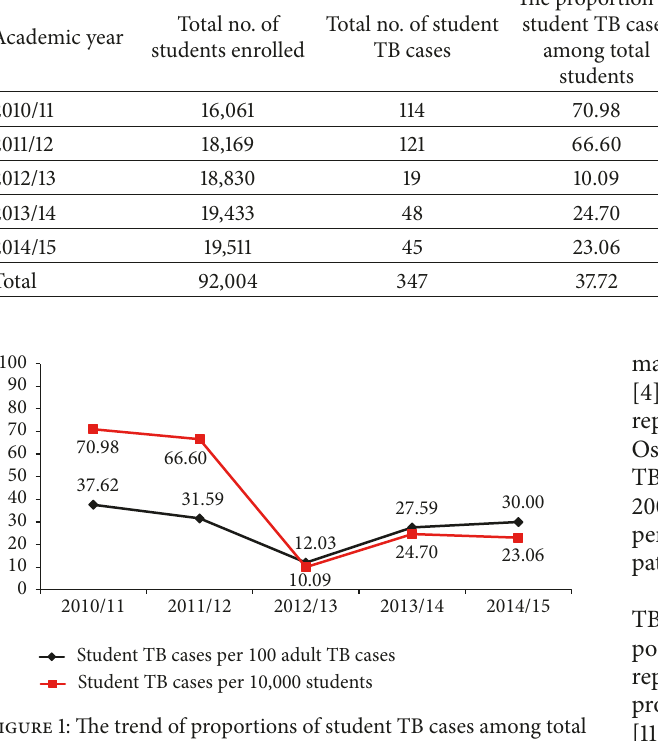
Figure 1: The trend of proportions of student TB cases among total adult TB cases and among total students, JUMC, 11 Sep. 2010-10